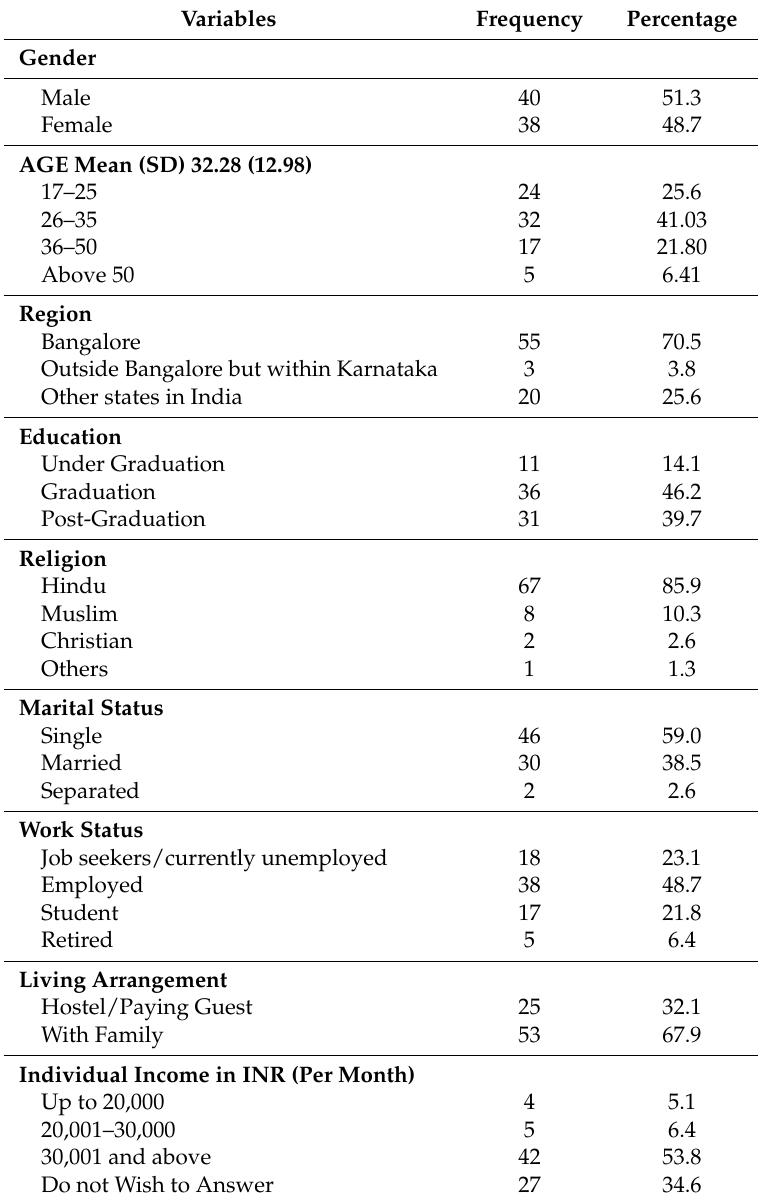
Table 3. PUSH-D trial sample characteristics-I ( n =